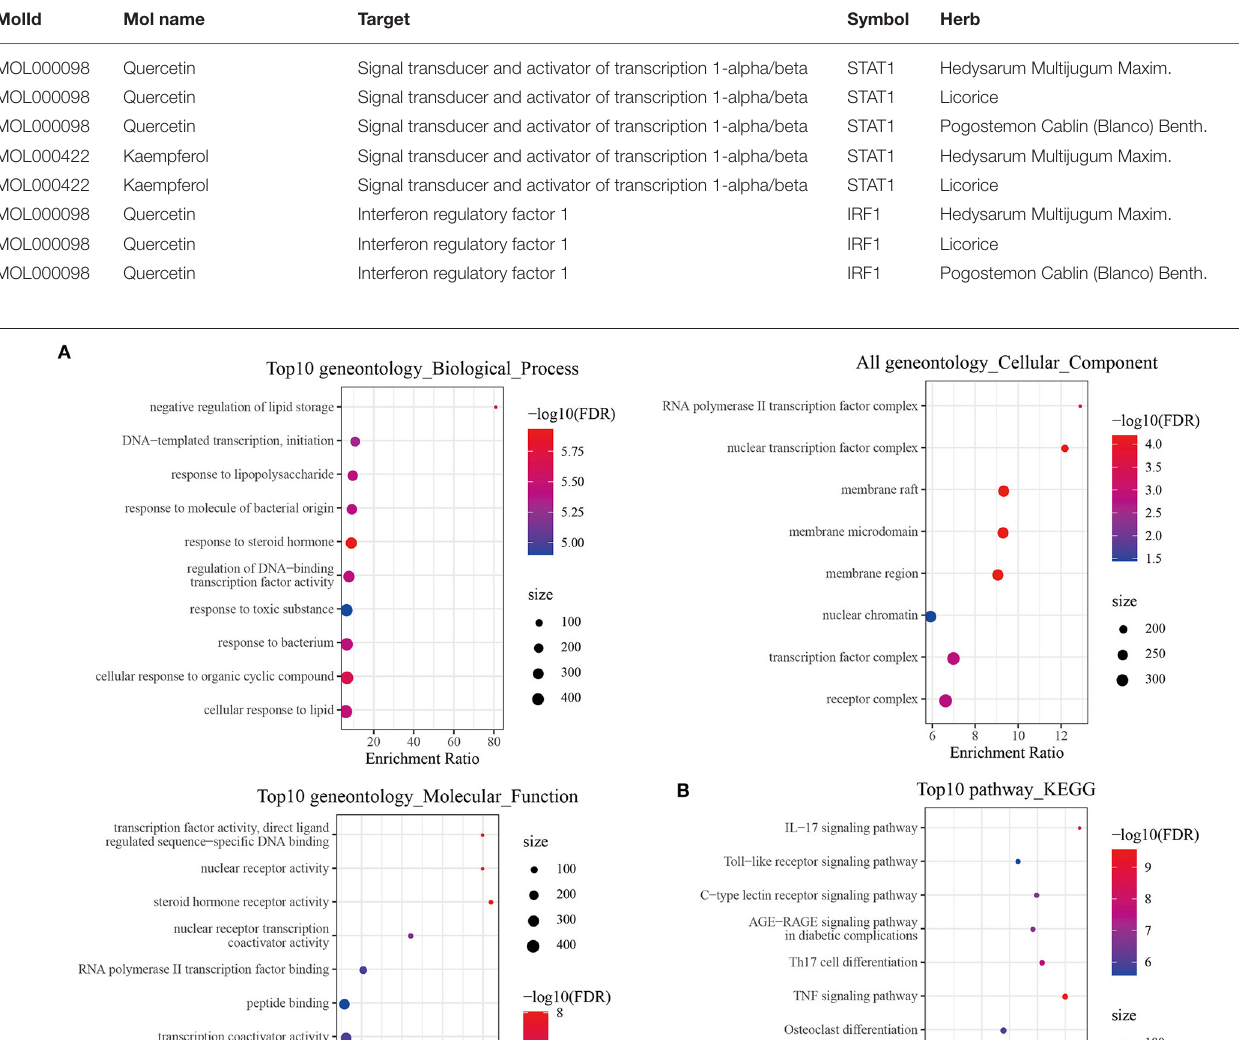
were associated with transcription factor complex and membrane raft. From MFs analysis, it could be found that the targets were mainly associated with nuclear receptor activity, steroid hormone receptor activity, peptide binding, etc. The enrichment analysis of KEGG signal pathways included 87 pathways. From the visual results of the first 10 pathways, the target gene of the main signaling pathways of prescription was concentrated in pathways in the IL − 17 signaling pathway, Th17 cell differentiation, TNF signaling pathway, Hepatitis B, etc. ( Figure 4B ). The GO function and KEGG enrichment results of the target genes